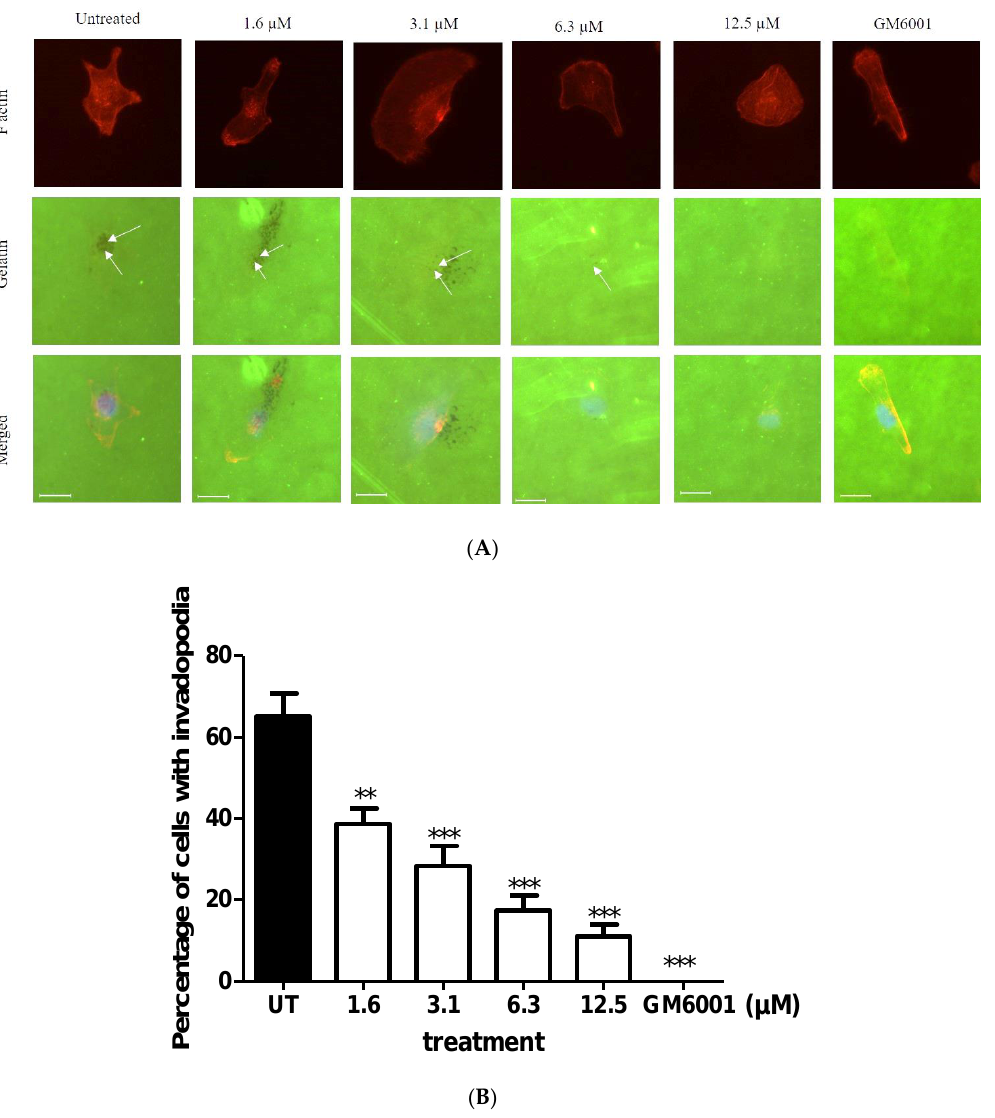
Figure 3. Effects of BHMC on gelatin degradation assay. ( A ) Cells seeded in a 6-well plate (5 × 10 4 cells/mL) were treated with indicated concentrations of BHMC for 24 h and then re-seeded (2 × 10 4 cells/mL) on Oregon Green 488 gelatin-coated coverslips for 3 h, fixed and stained for F-actin. Images were captured at a magnification of 400X. Arrows indicate the degradation on OG 488 gelatin. ( B ) Cells were scored for the presence of actin spots with underlying gelatin degradation for 100 cells for each condition. In all cases, the results are the mean ± S.E.M of three independent experiments. ** p < 0.01 and *** p < 0.001, which is significantly different from the untreated group. Scale bar = 20 µm.